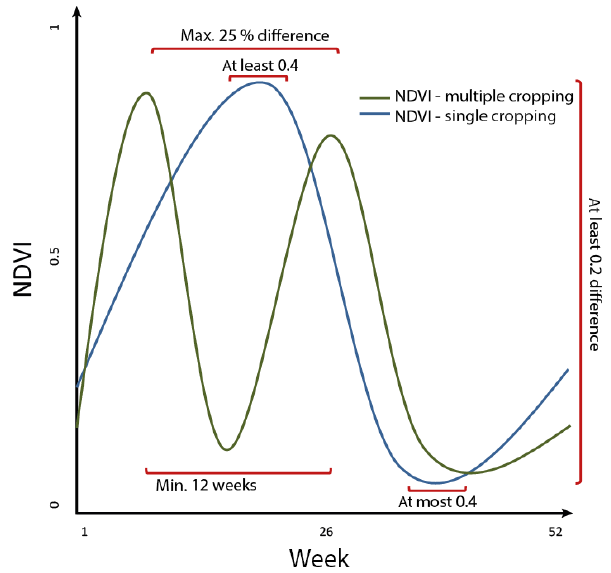
Figure 3. Idealized NDVI course of single and multi-cropping and the conditions which must be fulfilled.